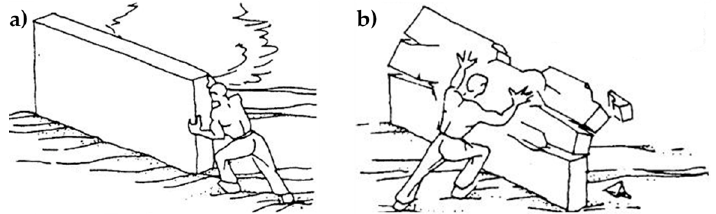
Figure 13. Loading of an unreinforced masonry (URM) wall: ( a ) shear loading in the midplane and ( b ) out-of-plane loading.